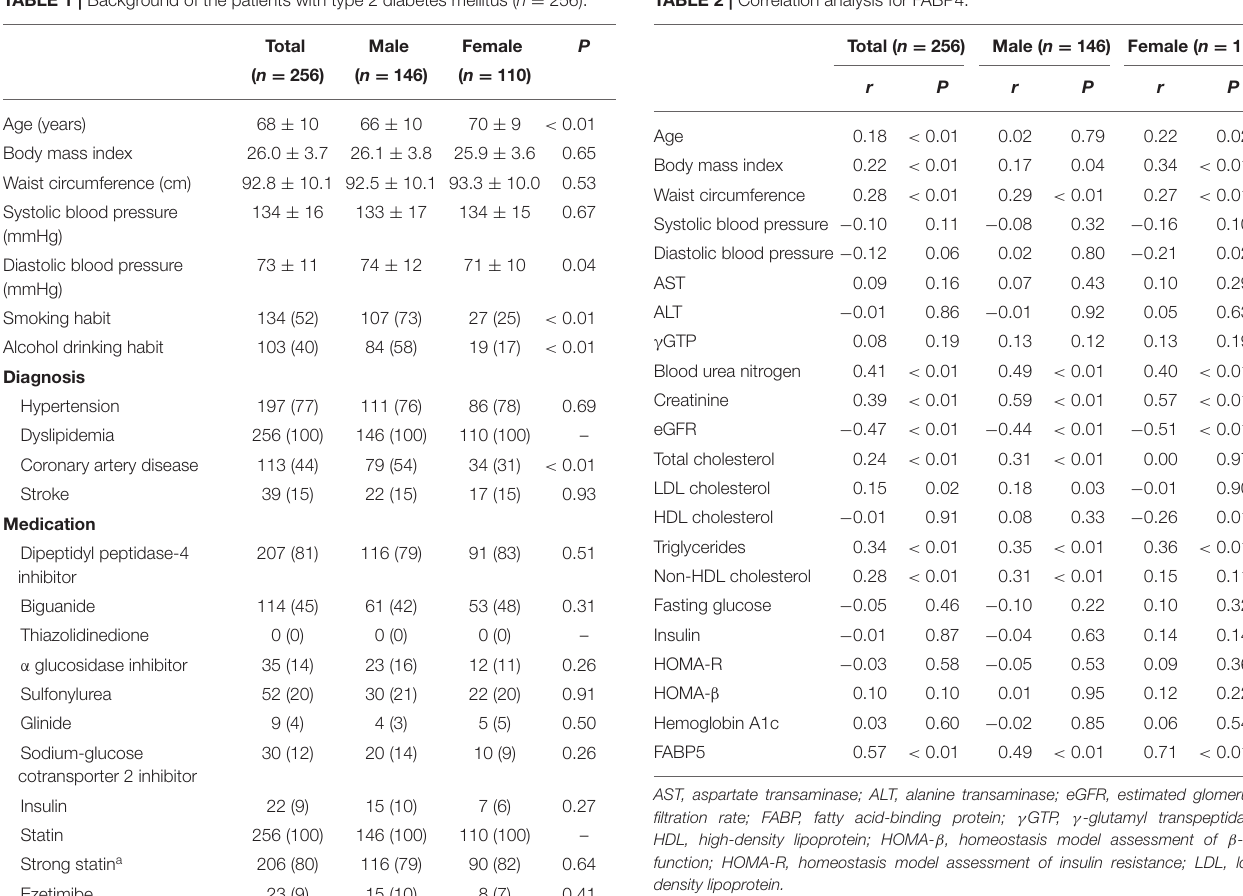
TABLE 1 | Background of the patients with type 2 diabetes mellitus ( n = 256). TABLE 2 | Correlation analysis for